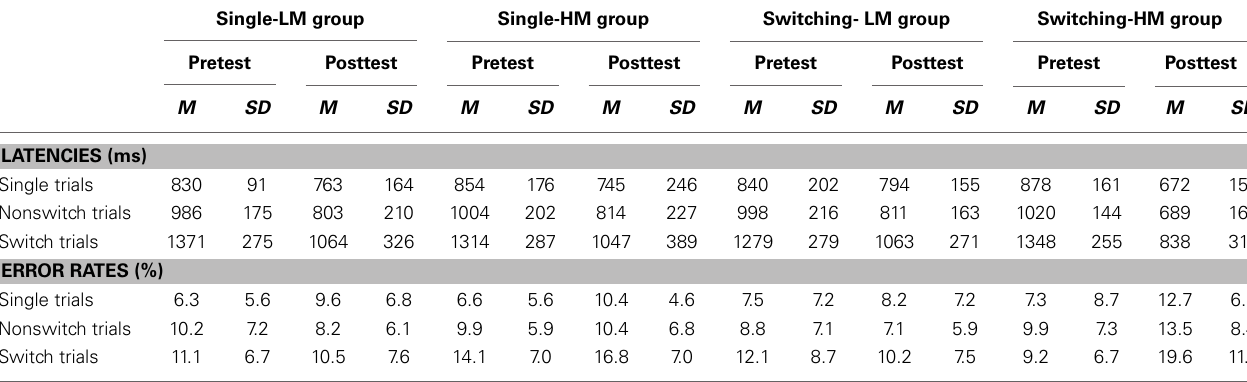
Table 3 | Performance on the near-transfer task as a function of Training Group (single-LM, single-HM, switching-LM, switching-HM) and Session (pretest,